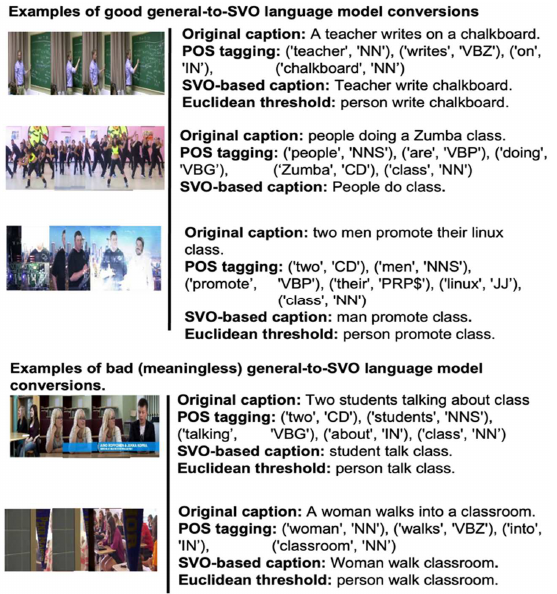
Figure 7. Examples of good and bad conversions of captions from the natural language descriptions to the SVO-based captions used in our framework. Table 2. Selected hyperparameters for tuning while training the two proposed models. Model